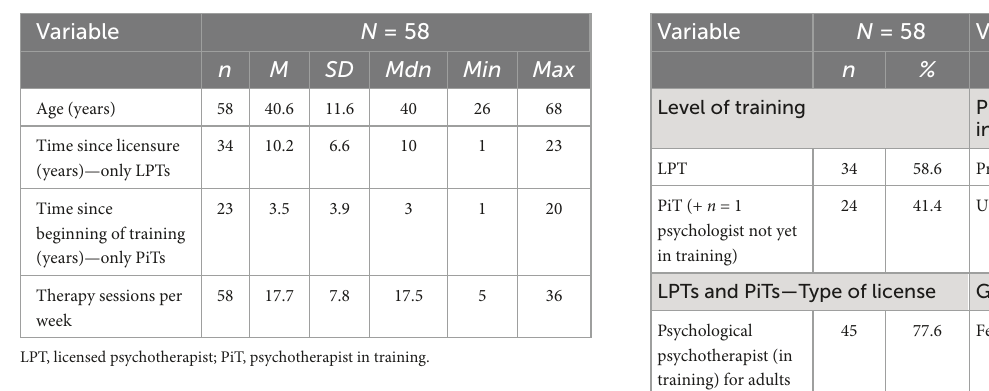
TABLE 1 Demographic information of participants. TABLE 2 Demographic information about the participants.